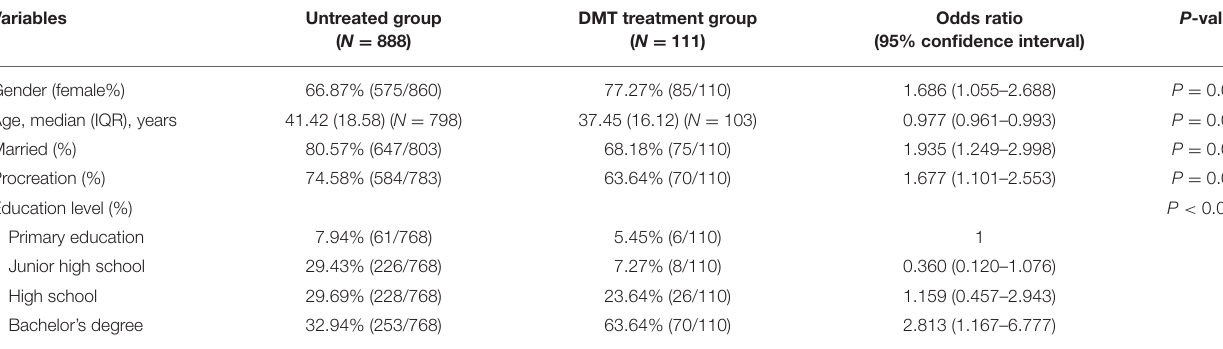
TABLE 6 | Patient characteristics of the DMT treatment group and untreated group.